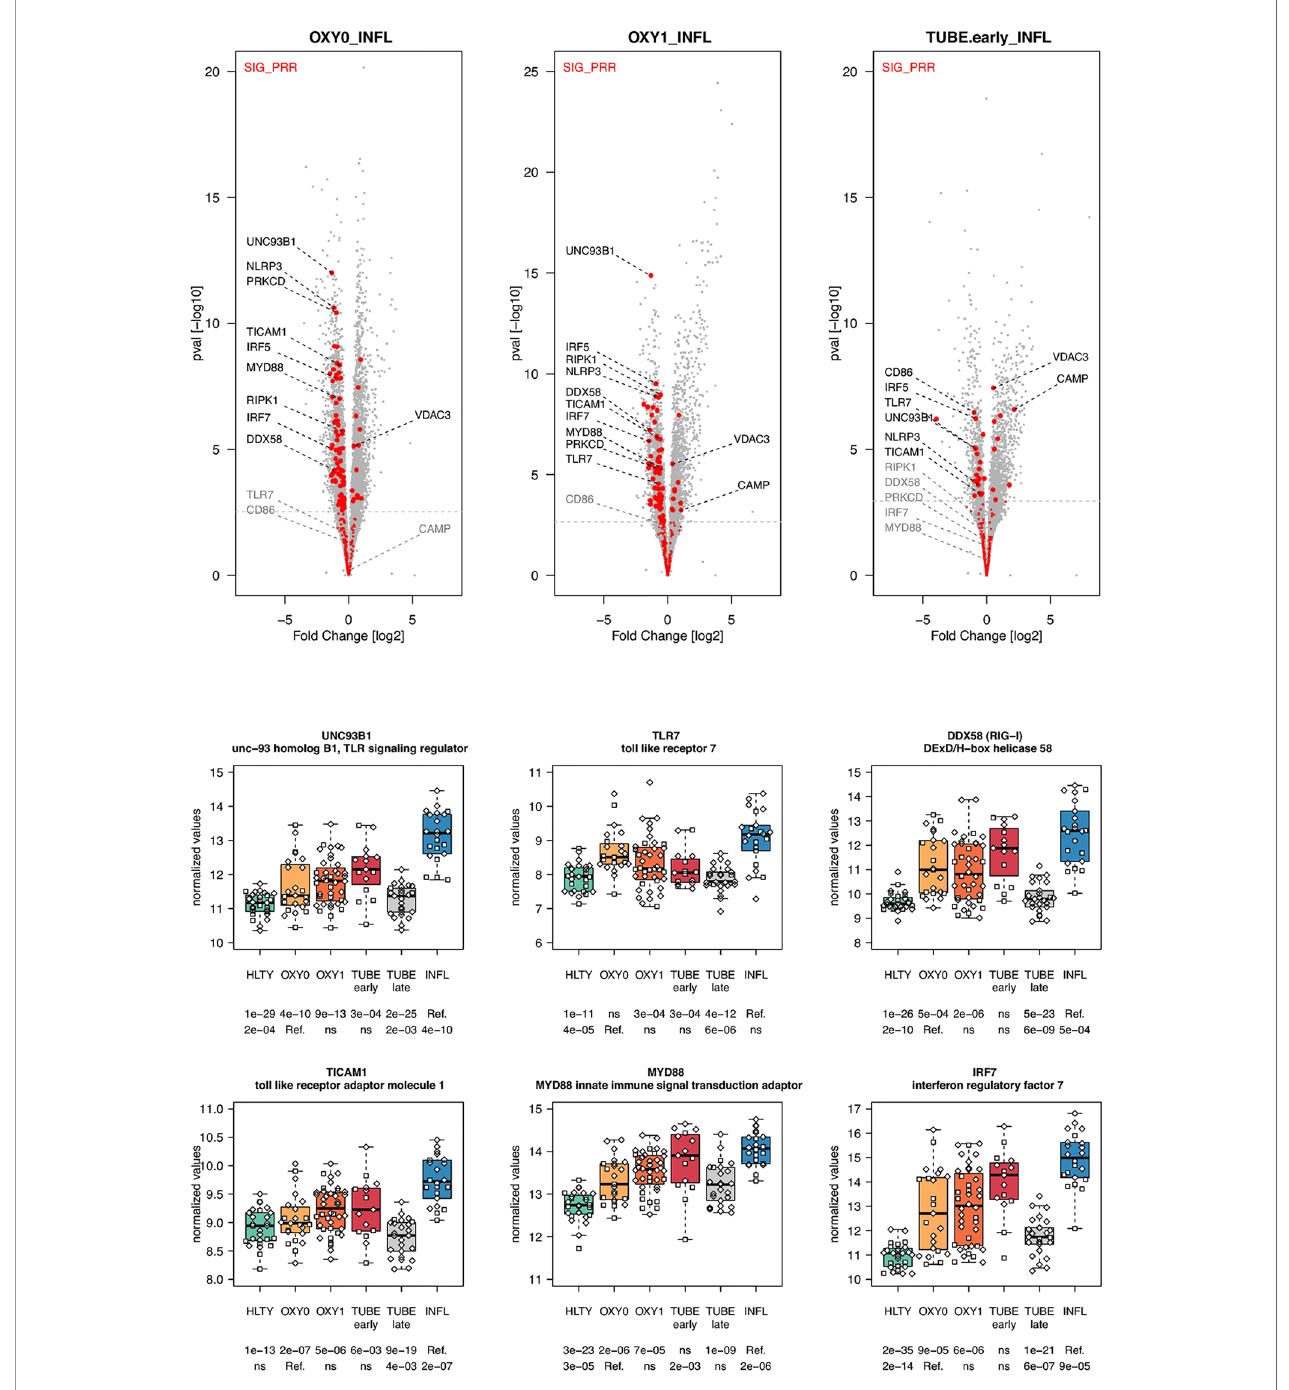
FIGURE 3 | Differentially expressed genes (DEGs) involved in innate immune detection of viruses. Upper panel: for each comparison indicated in the volcano plot header, the distribution of log2 fold changes and P-values of all detected genes is shown as gray dots. Red dots indicate genes included in the SIG_PRR gene set (innate immune detection of viruses and downstream signal transduction). Genes ’ sets are selected from different GO, REACTOME and/or KEGG pathways (see Supplementary Table 2 ). The dotted horizontal gray line indicates the limit under which – log10(P-value) becomes non signi fi cant once adjusted for multiple testing (adjusted P > 0.01). Lower panel shows detailed expression levels for selected genes. Groups used for comparisons include SARS-Cov-2 infected patients (no oxygen support [OXY0], oxygen support [OXY1], intubation with sampling within 7 days [TUBE early] or >7 days [TUBE late] after hospital admission), In fl uenza virus [INFL] infected patients and non-infected controls [HLTY]. Adjusted P-values of pairwise comparisons between a reference group (Ref.) and another group are indicated below the x axis. Ref. is taken as [INFL] and [OXY0] on the fi rst and second line,